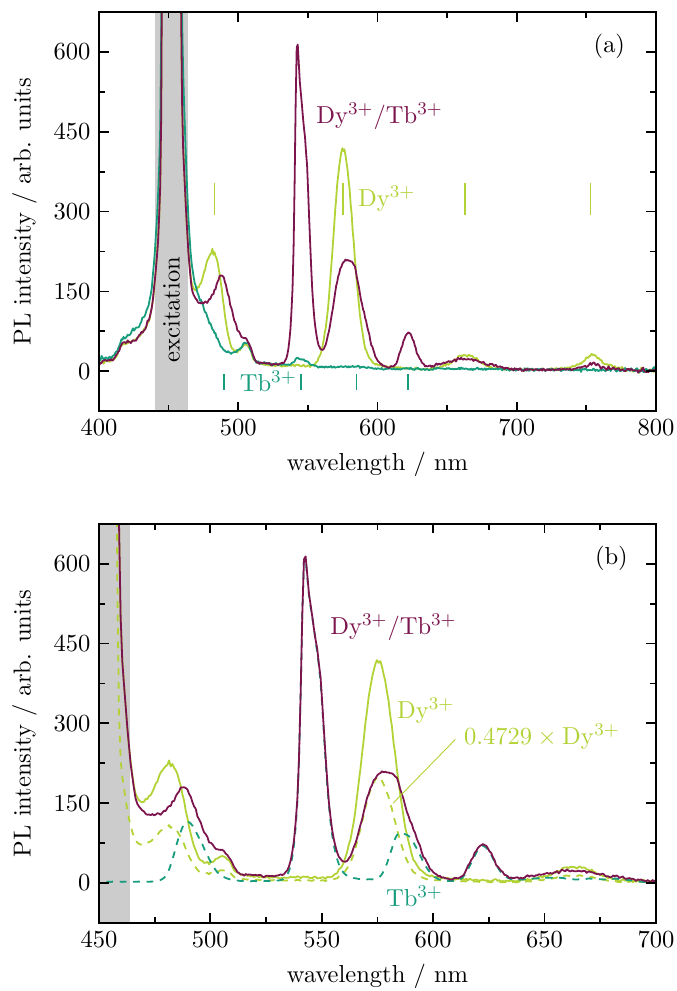
Figure 6. ( a ) Photoluminescence (PL) emission spectra of Dy 3 + (0.45at.%) and Tb 3 + (0.90at.%) single-doped as well as Dy 3 + /Tb 3 + (0.45at.%/0.89at.%) double-doped BaB glasses; the emission spectra are recorded under 452-nm excitation. ( b ) Deconvolution of the emission spectrum of the Dy 3 + /Tb 3 + double-doped BaB